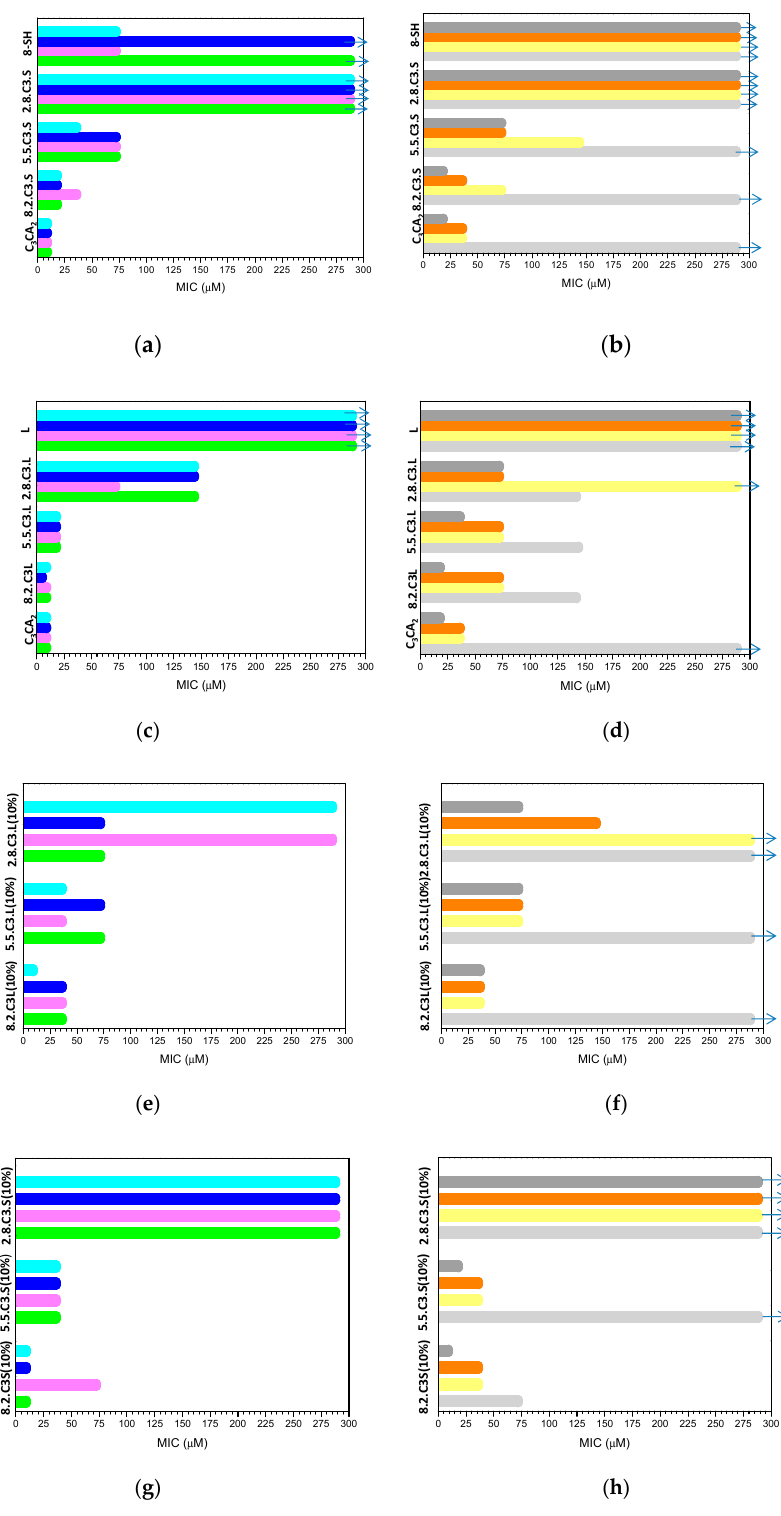
Figure 6. MIC ( μ M) of pure surfactants as well as their catanionic mixtures without and with (10%) cholesterol against Gram-positive and Gram-negative bacteria: ( a ) C3S mixtures against Gram-positive bacteria ( b ) C3S mixtures against Gram-negative bacteria, ( c ) C3L mixtures against Gram-positive bacteria, ( d ) C3L mixtures against Gram-negative bacteria, ( e ) C3L(10%) mixtures against Gram-positive bacteria, ( f ) C3L mixtures against Gram-negative bacteria, ( g ) C3S (10%) mixtures against Gram-positive bacteria and ( h ) C3S (10%) mixtures against Gram-negative bacteria (cid:4) MRSA (cid:4) B. subtilis (cid:4) K. rhizophila (cid:4) S. epidermidis (cid:4) K. pneumoniae (cid:4) P. aeruginosa (cid:4) E. coli (cid:4) C. albicans . Arrows indicates that the highest concentration tested did not inhibit the growth of the